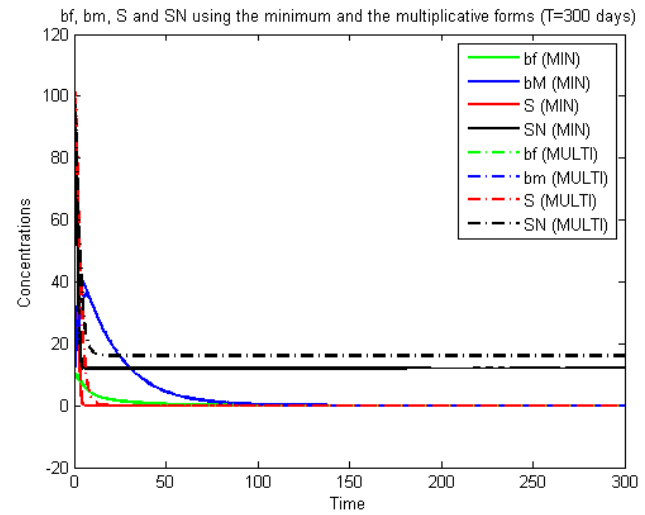
Figure 11. Concentrations of the ODE model using the minimum and the multiplicative formulas (T = 300